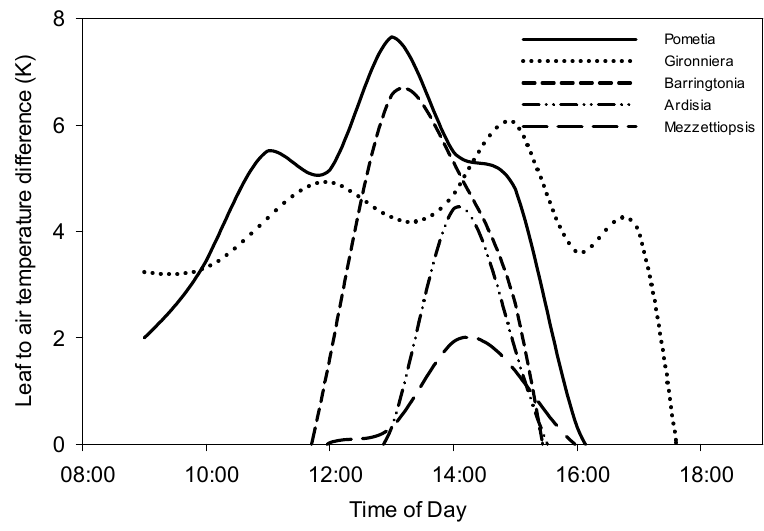
Figure 4. Leaf to air temperature difference of the five tree species.